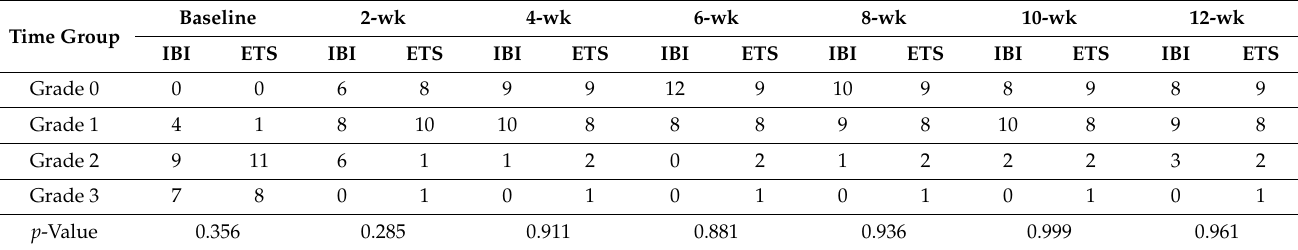
Table 3. Distribution of patients among HDSS grades as determined during the 12-week follow-up